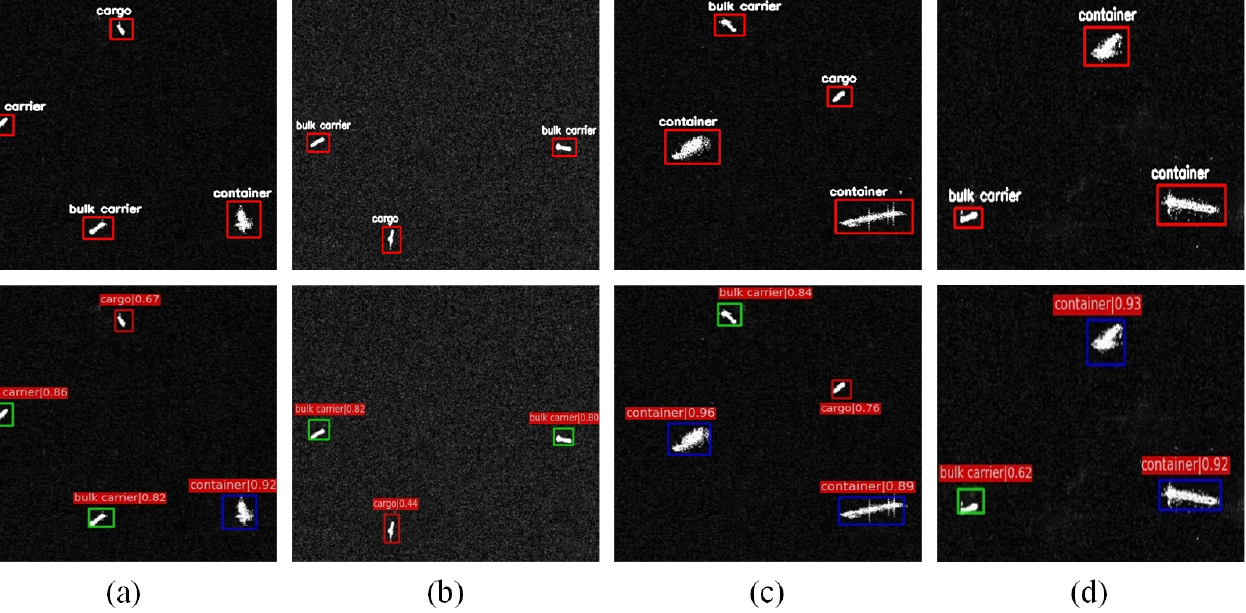
Figure 6. Simple background ship target experiments. All images at the top are images with truth boxes, and the images at the bottom are images of the detection results of our method.